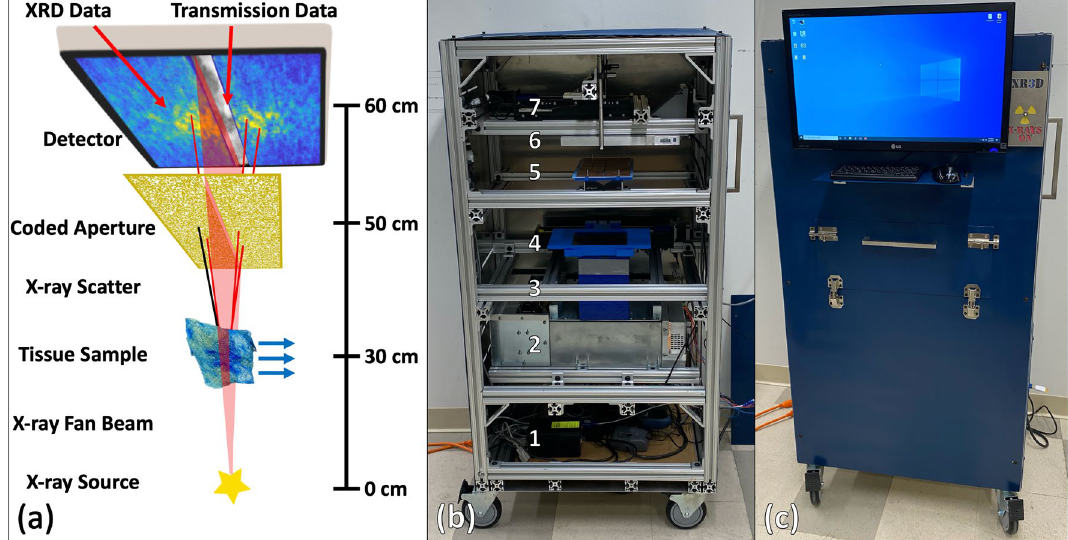
Figure 1. The X-ray fan beam coded aperture scanner developed in this work. ( a ) Schematic representation of the scanner, with blue arrows representing scanned materials being translated through the X-ray fan beam to collect transmission and XRD data for the entire sample. Images on the detector represent the captured transmission data (greyscale) and multiplexed XRD data (blue-yellow) that are captured sequentially. ( b ) Internal components of scanner with labels corresponding to (1) computer/controllers, (2) X-ray generator, (3) collimation to produce fan beam, (4) motorized tray for translating materials through fan beam, (5) coded aperture with central slit for fan beam, (6) X-ray detector and (7) motorized lead block for shielding fan beam during XRD data acquisition. ( c ) Finished system with internal lead shielding, monitor, and access panel